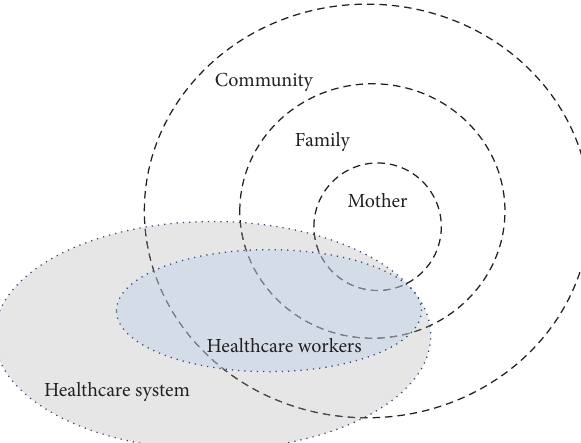
Figure 1: Conceptual diagram of the different layers of influence on breastfeeding patterns. Note: the size of the circle does not correlate with the potential influence that each category may exert on breastfeeding